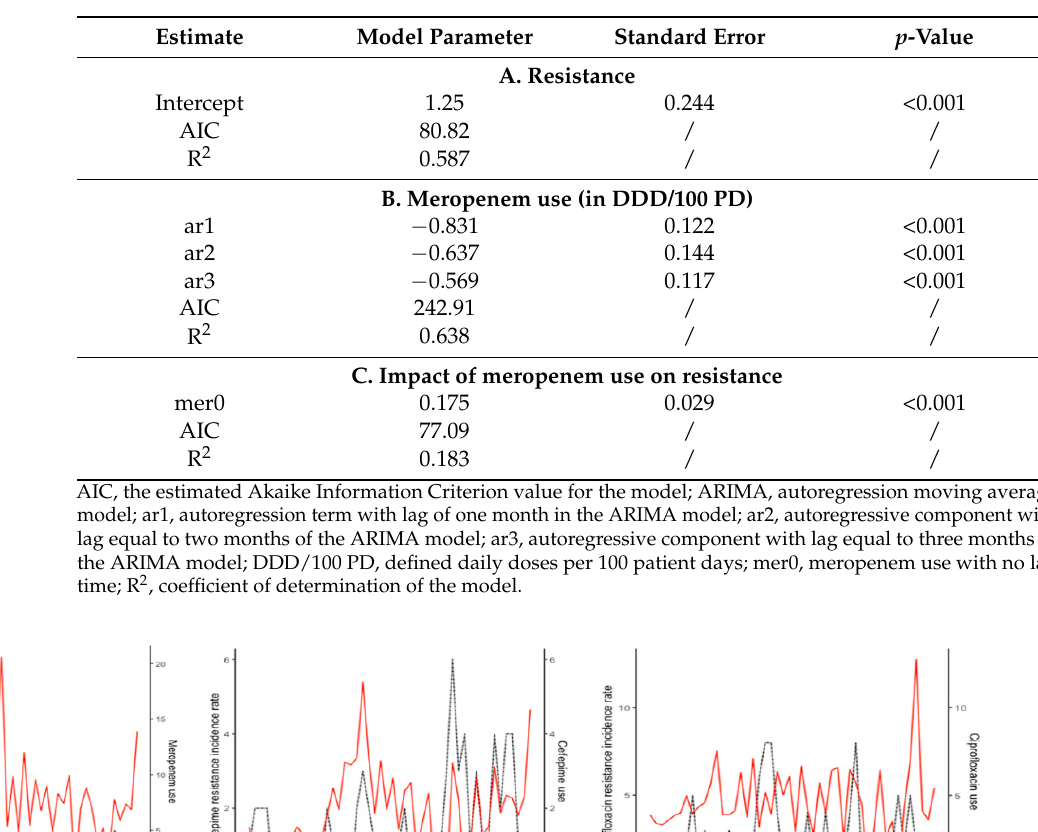
Table 3. ARIMA models for meropenem-resistant P. aeruginosa ( A ) and meropenem use ( B ). Dy-